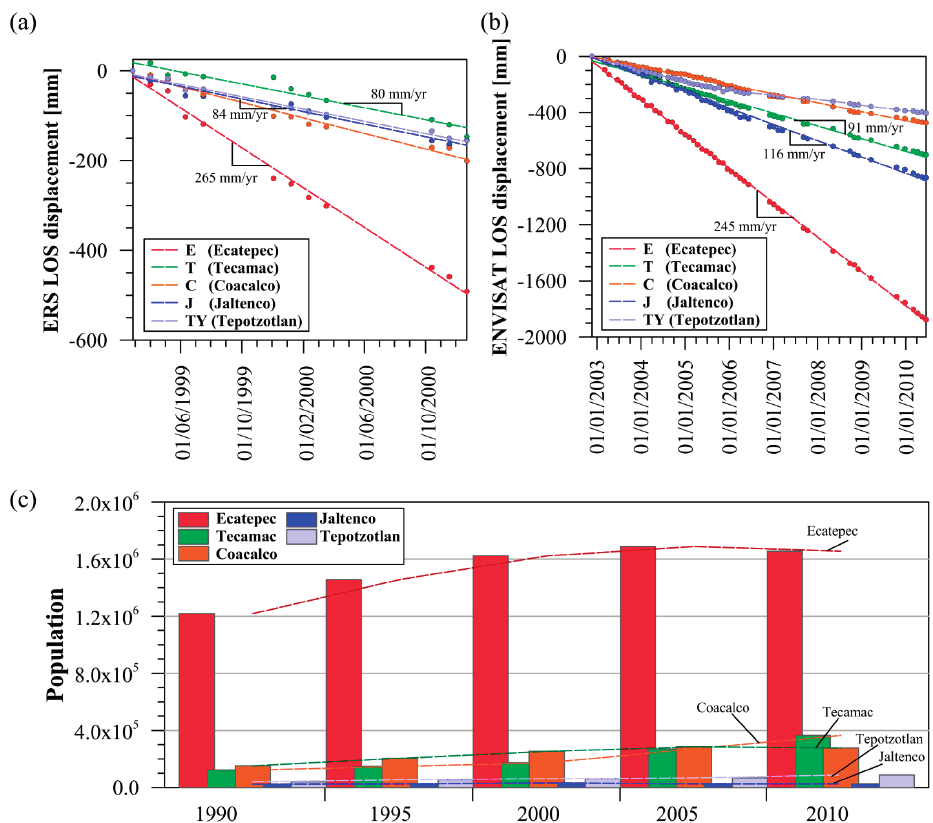
Figure 4. Displacement time series in LOS of SDFP pixels E, T, J, C and TY (Figure 3) corresponding to: ( a ) ERS and ( b ) ENVISAT data sets; ( c ) Population evolution for the period 1990–2010 [27]. Dashed lines in panels ( a – c ) indicate the corresponding tendency